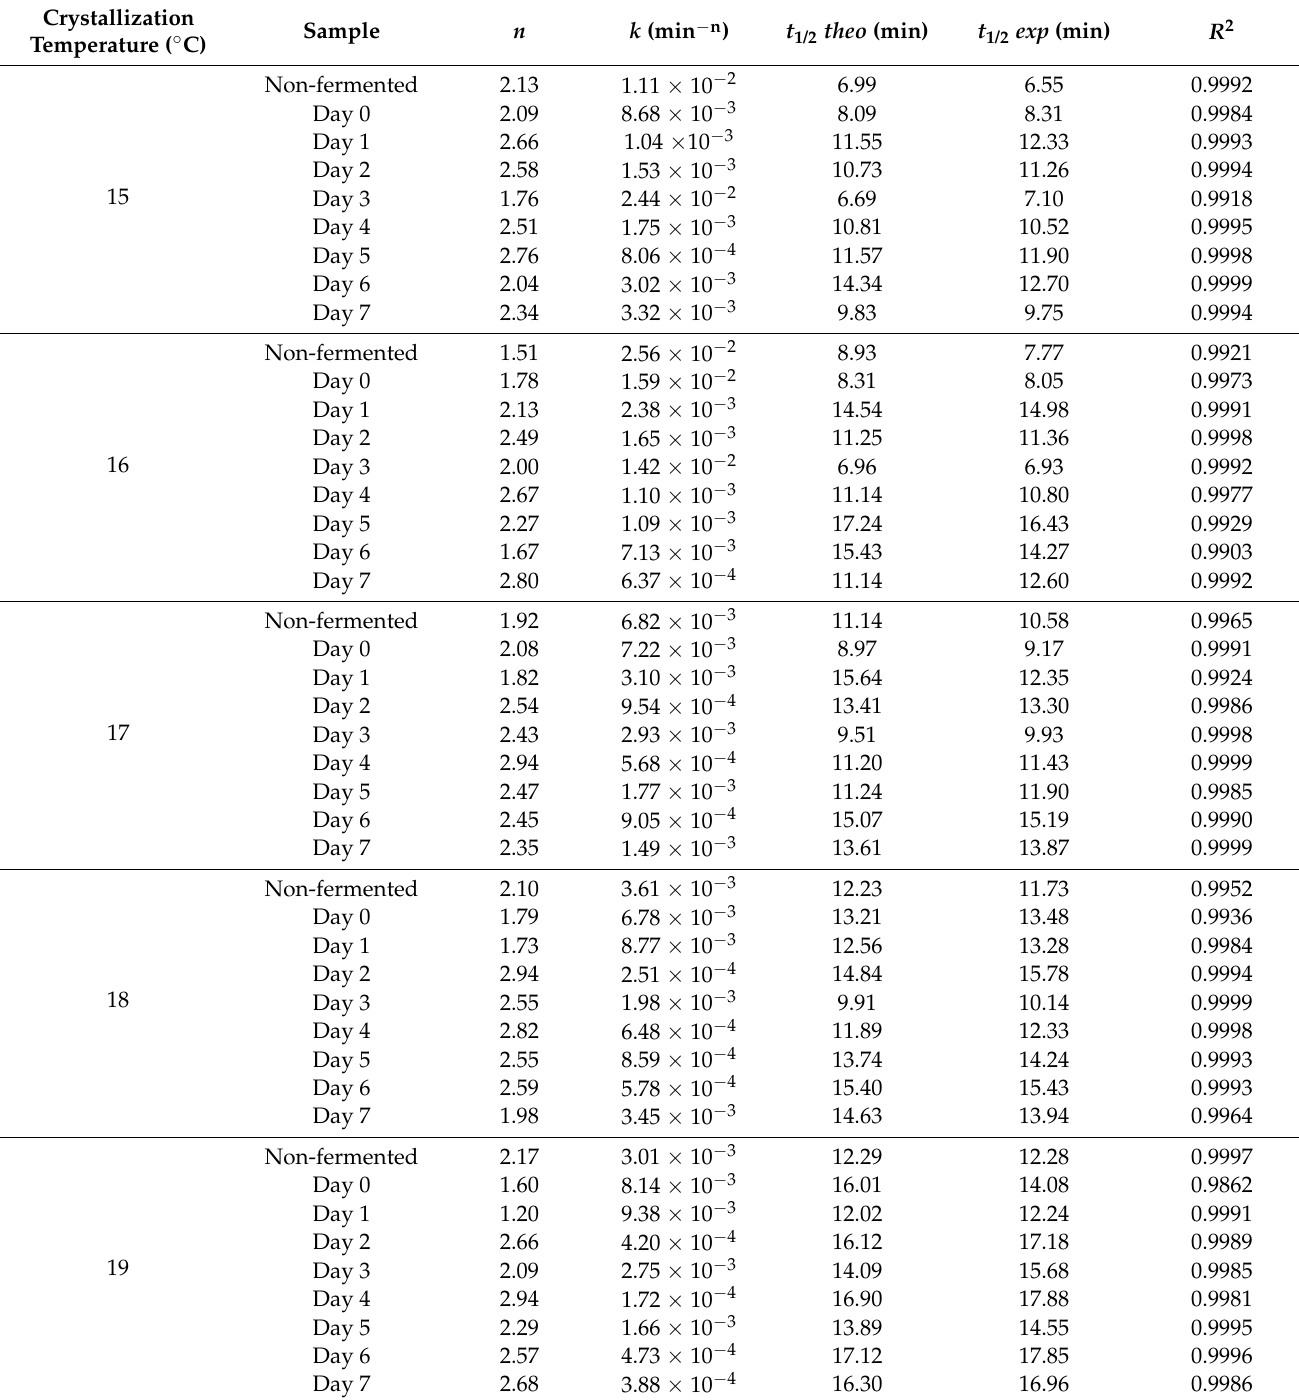
Table 4. Kinetics of crystallization parameters of CB inside cocoa beans during spontaneous